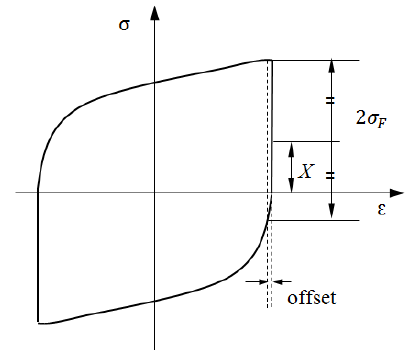
Figure 6. Determination of the back stress and the friction stress from the hysteresis loop.